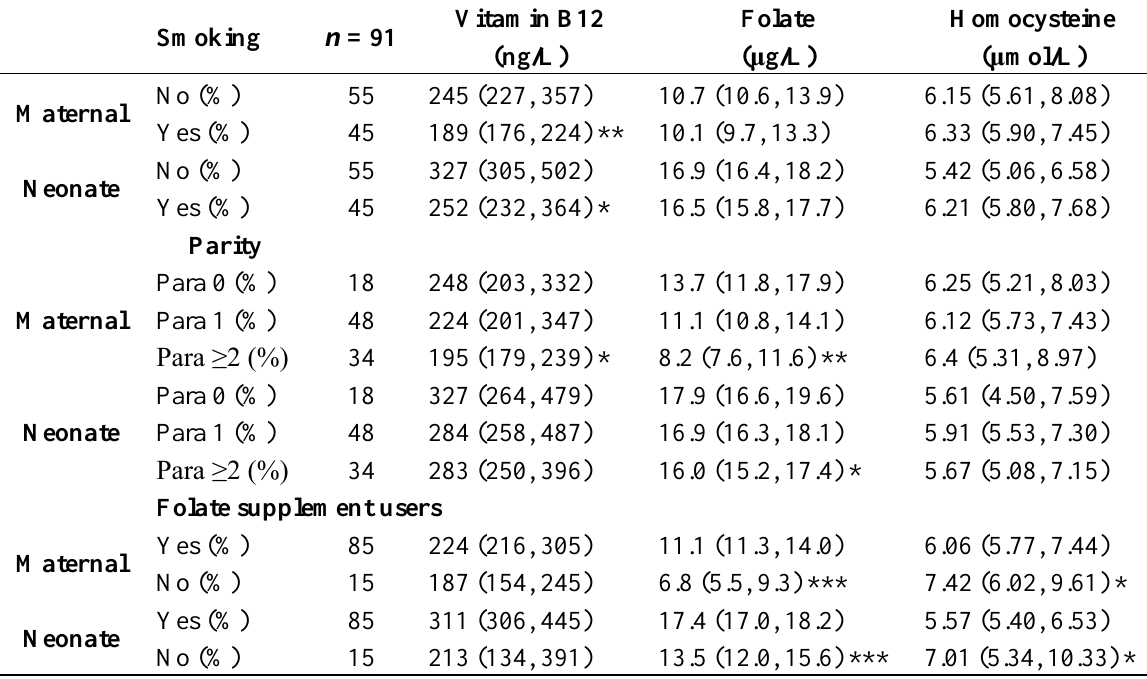
Table 3. Vitamin B12, folate and homocysteine in mothers and neonate according to maternal smoking status, parity and folate supplement